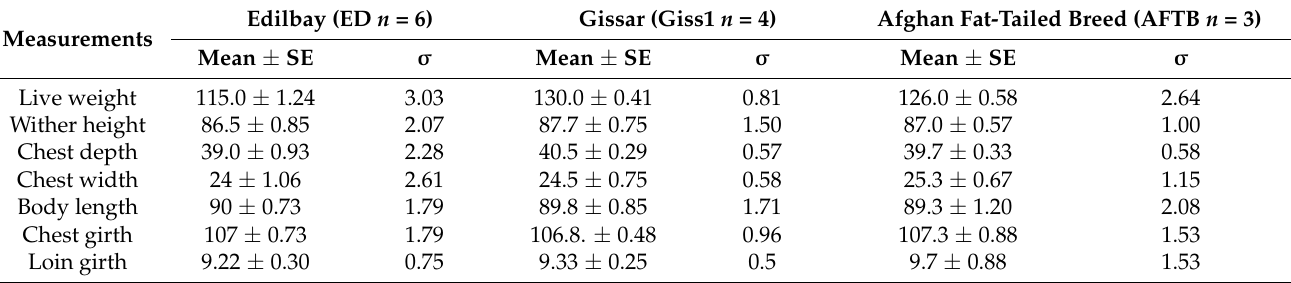
Table 1. Measurements of the rams used to create the